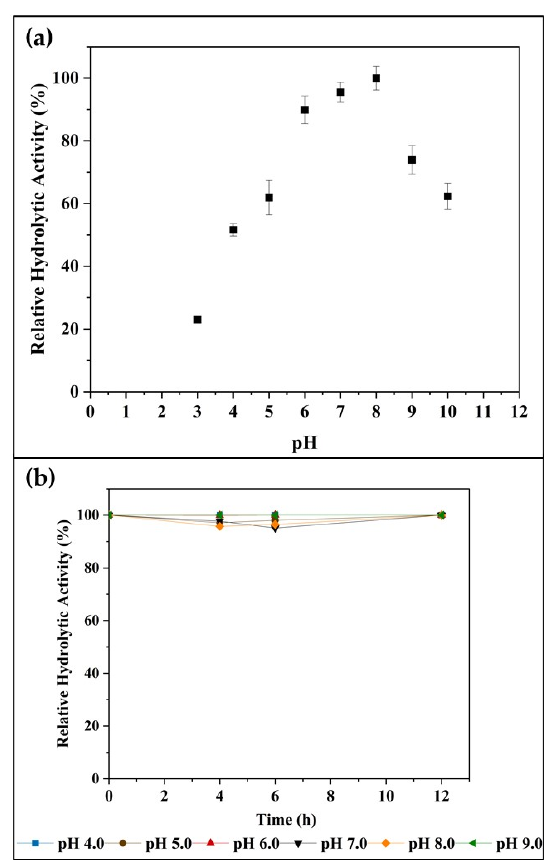
Figure 5. Characterization of A. japonicus lipase immobilized in MKSF support in relation to optimal pH ( a ) and pH stability through time (until 12 h of incubation) ( b ). These experiments were performed at 30 °C. In the optimal pH, 100% is related to the highest hydrolytic activity achieved. In the pH stability studies, the initial activity obtained at time zero to each pH was considered 100% (different values for each pH values). The error bars represent the standard deviation of triplicates.